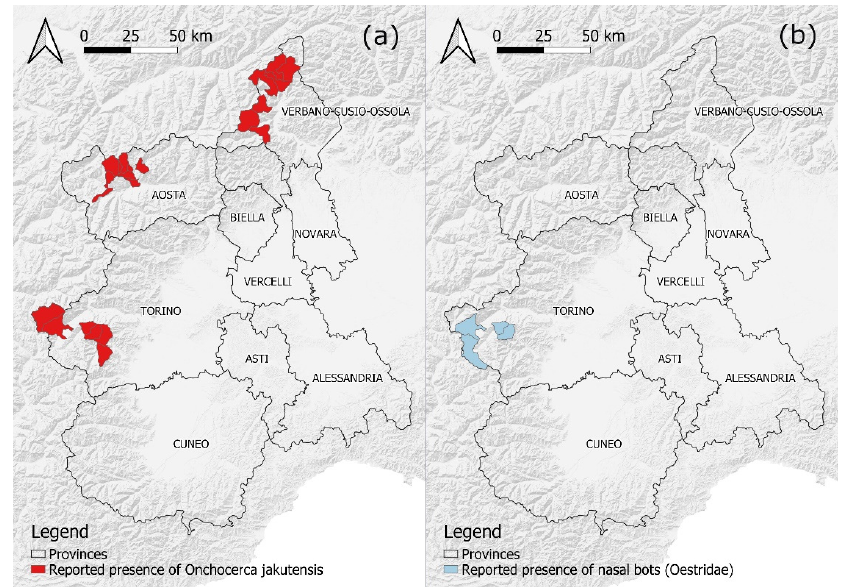
Figure 3. Location (by municipality) of the cases of nodular onchocercosis reported in the surveyed